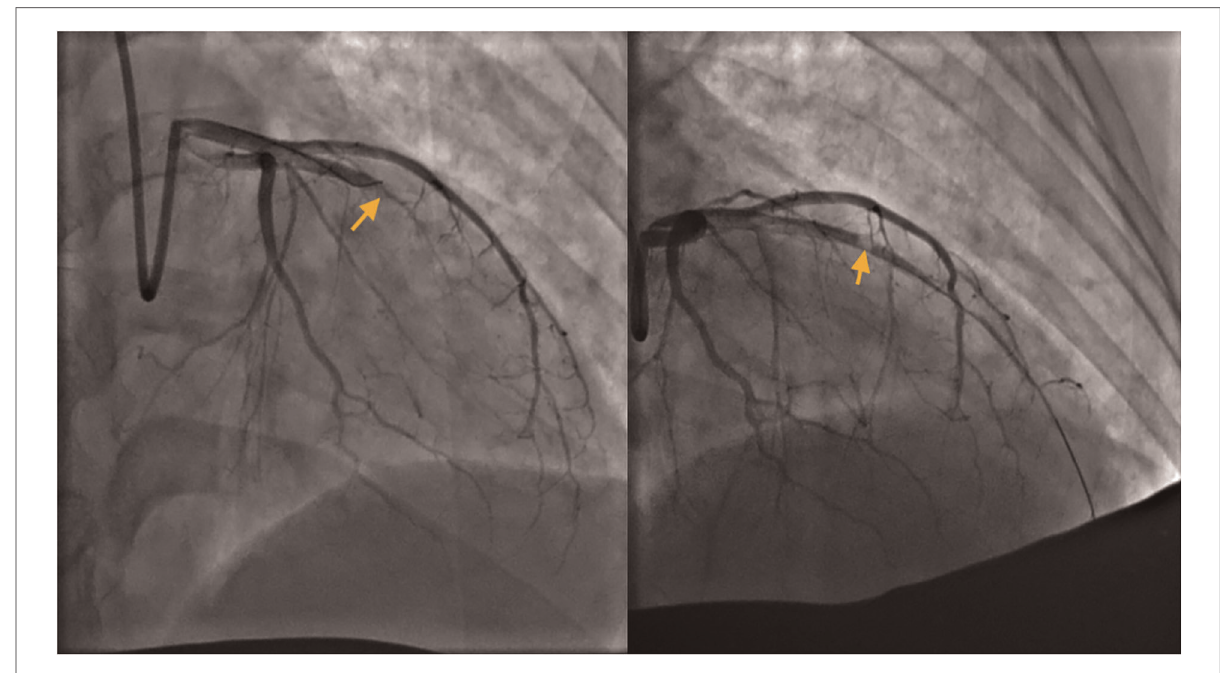
FIGURE 2 Left: Left anterior descending (LAD) artery: critical lesion in mid LAD. Right: The guide wire passed through the occlusion.